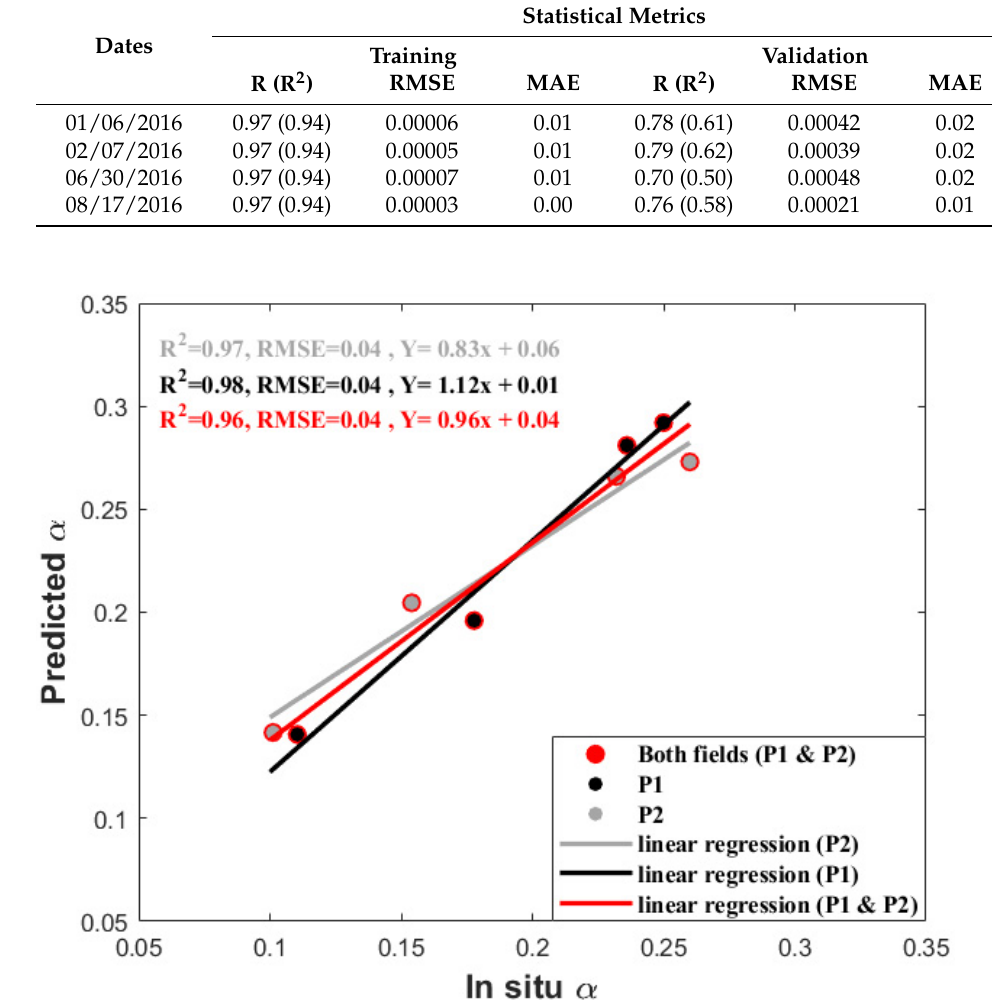
Figure 9. Comparison between predicted and in situ estimates of surface albedo for drip- (P2) and flood- (P1) irrigated sites.